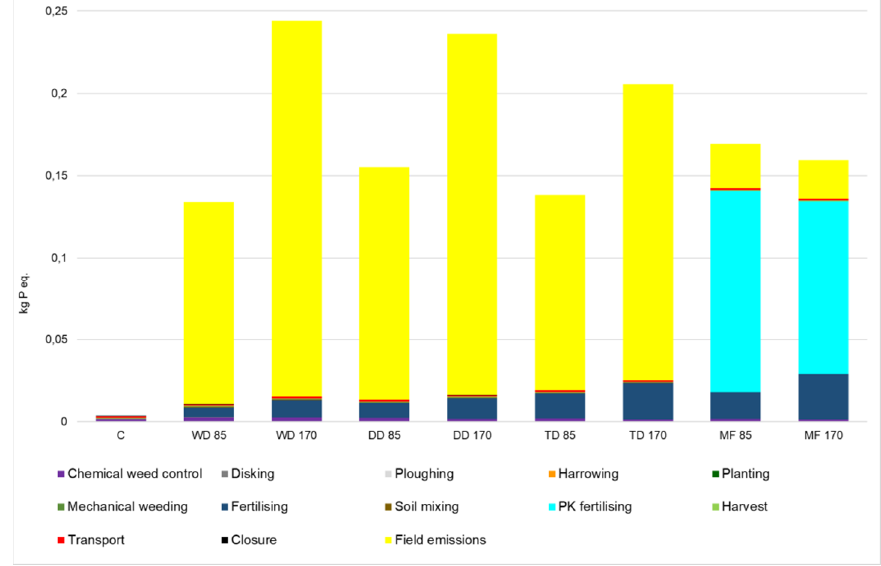
Figure 6. Freshwater eutrophication per 1 Mg d.m. of miscanthus in different fertilisation treatments.